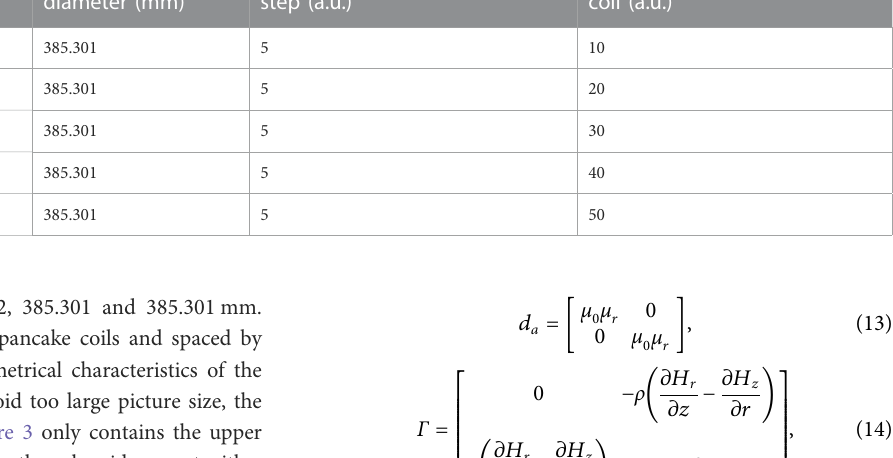
TABLE 2 Geometric parameters of the solenoid magnet with a trapezoidal section. Step index Inner Outer Number of coils in each diameter (mm) diameter (mm) step (a.u.)